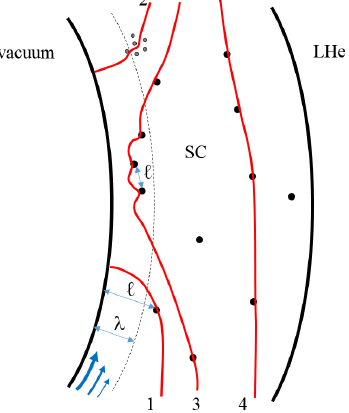
FIG. 1. A sketch of the curved cavity wall with trapped vortices in the equator region (not in scale). Dots represent pinning centers, and red lines represent flexible line vortices. The rf current flows in the inner surface layer within the London penetration depth ∼ λ . Vortices 1 and 2 have segments normal to the surface, 1 is pinned by one strong pin, and 2 is pinned collectively by several weak pins. Vortex 3 has two pinned segments parallel to the surface within λ . Vortex 4 is not exposed to the rf field and does not contribute to rf losses.